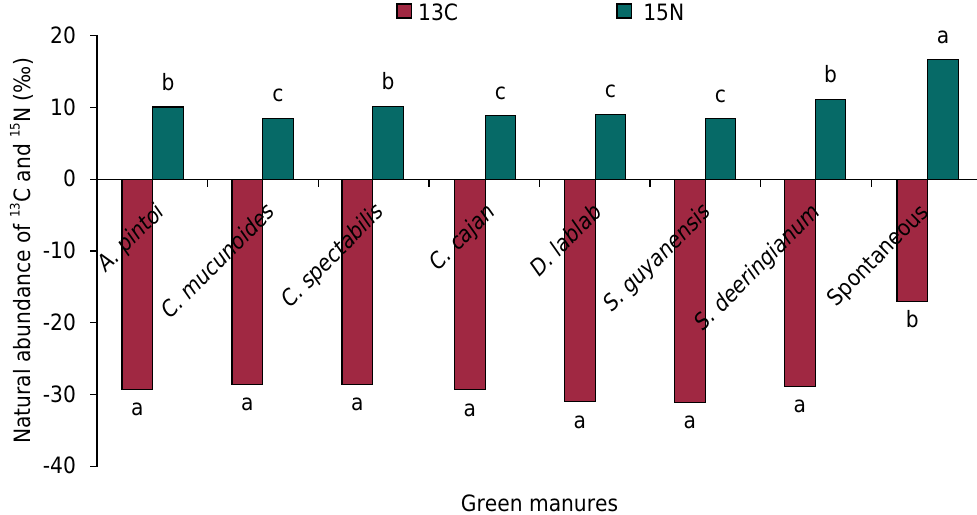
Figure 2. Natural abundance of 13 C (δ 13 C) and 15 N (δ 15 N) for dry matter of the legumes and spontaneous plants intercropped with coffee in the Zona da Mata region, state of Minas Gerais, Brazil. Means followed by the same letter do not differ at the 5 % level of probability by the Scott-Knott